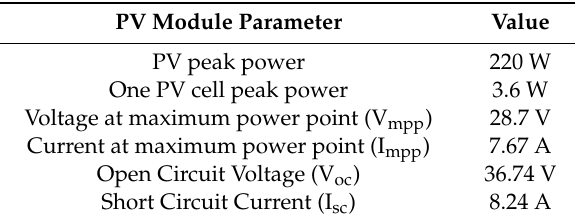
Table 1. PV modules electrical